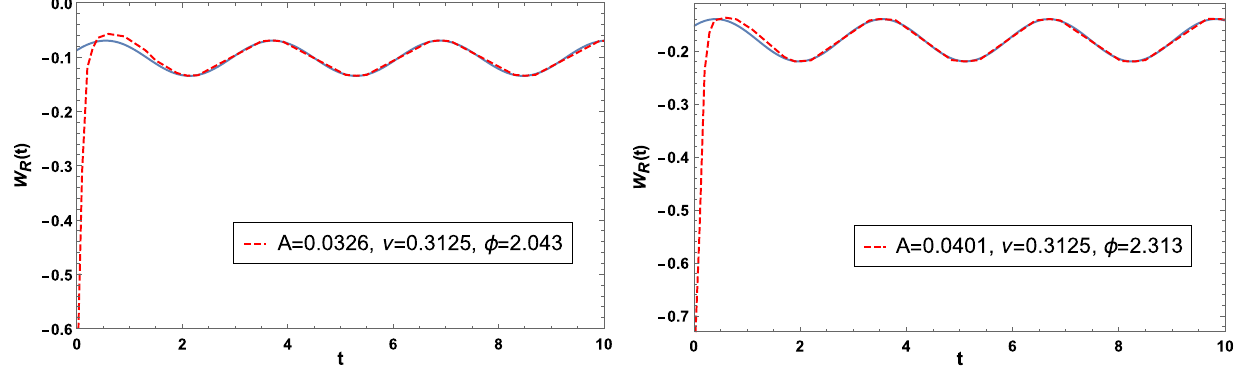
Fig. 7 W R ( t ) in terms of boundary time t for k = 0 . 3 and l = 1. For the left panel μ f = 0 . 3925, T f = 0 . 1246 and for the right panel μ f = 0 . 6981, T f = 0. The static potential is V ( l ) = − 0 . 3347 ( − 0 . 3912)